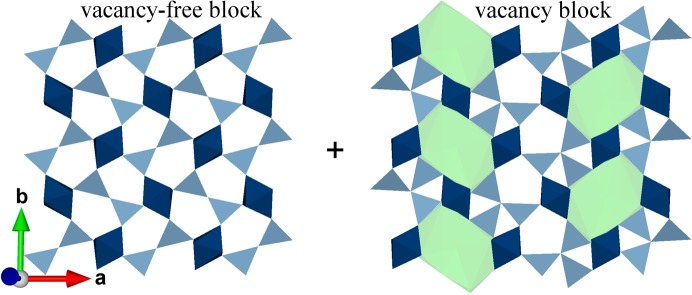
Construction of mullite supercells by combining vacancy-free blocks and vacancy blocks with a composition-adapted length. The shown vacancy block has a length N
V of two vacancies. Along c vacancy blocks are stacked upon vacancy-free blocks and vice versa.